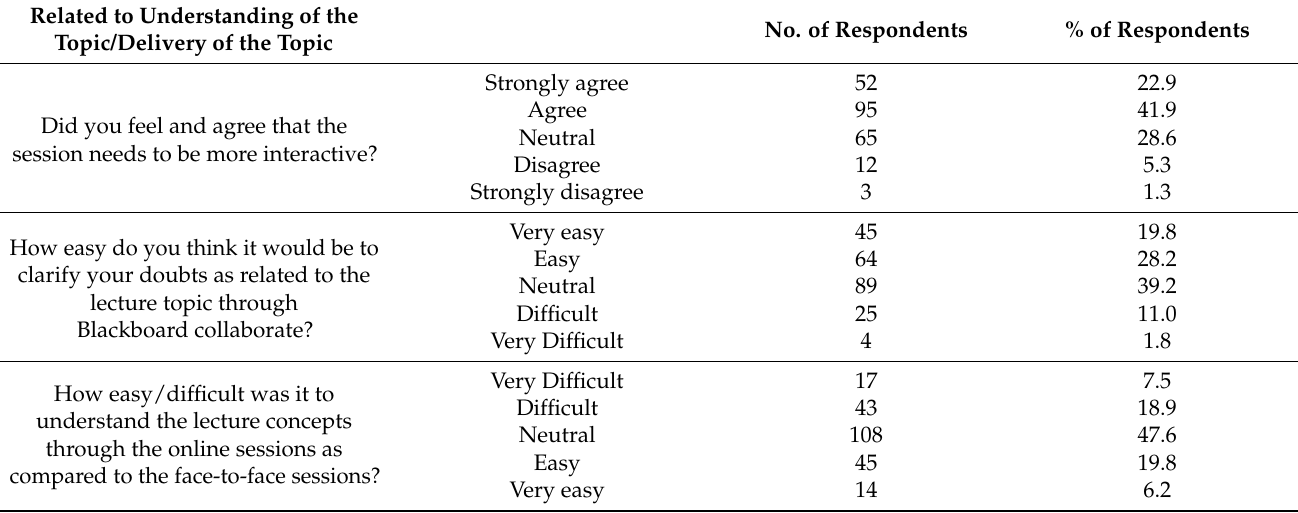
Table 4. Distribution of responses related to understanding of the topic/delivery of the